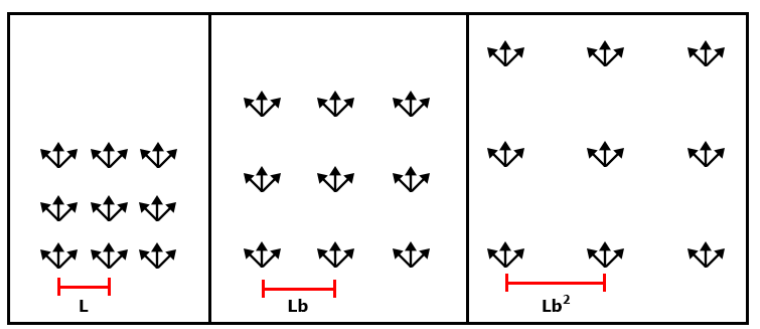
Figure 5. Example of AGVS performed using different scale values of b 0 , b 1 , and b 2 , respectively, multiplied by the discretization length L .